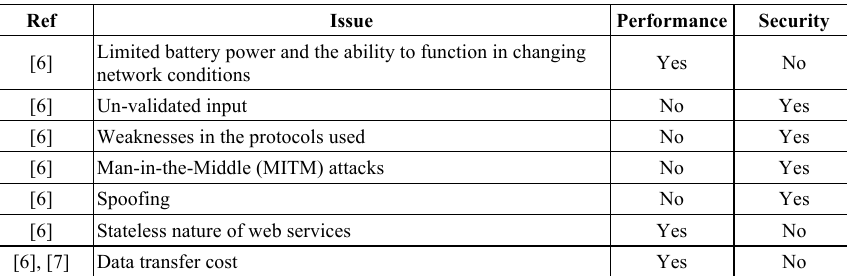
Table 1. Open issues in web